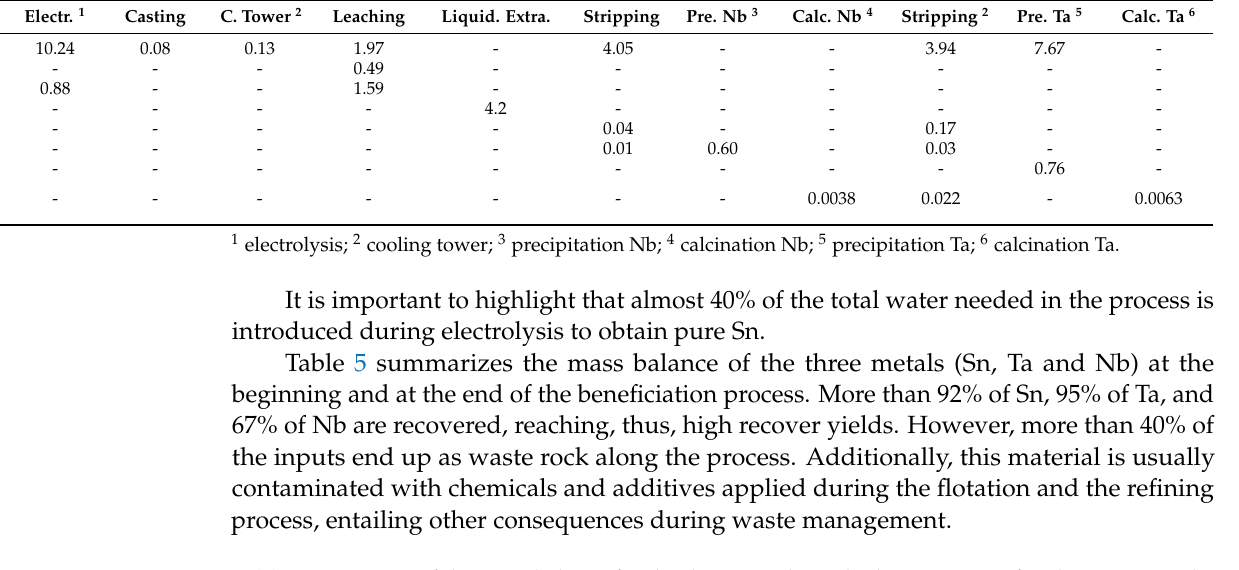
Table 5. Summary of the mass balance for the three metals studied using a ton of rock as input in the metallurgy